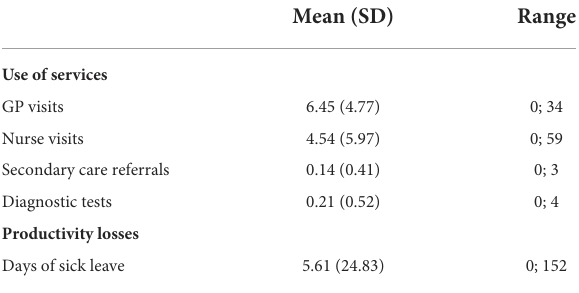
TABLE 5 Data quality for use of services (number of services used) and productivity losses (number of days of sick leave) ( N prescriptions =